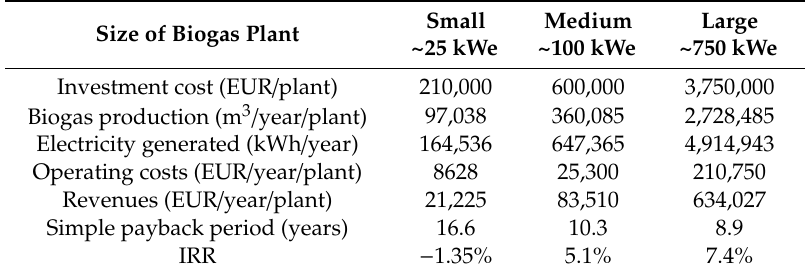
Table 8. Economic feasibility of CHP biogas plants in